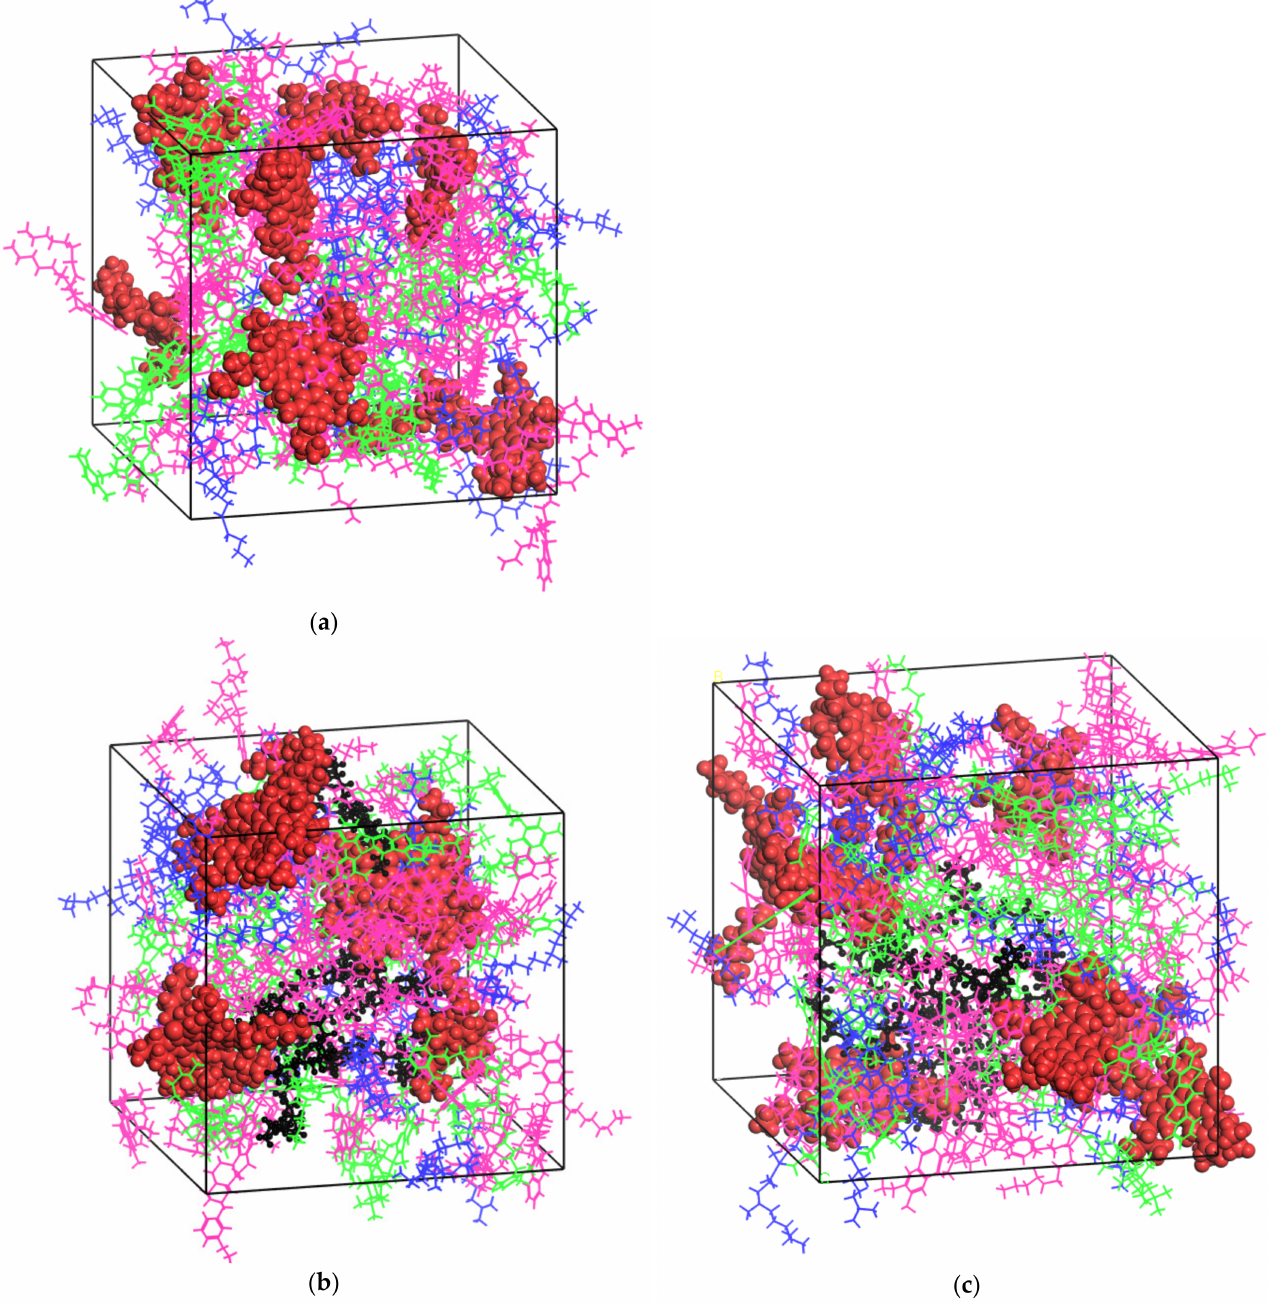
Figure 10. Interaction morphology of virgin asphalt ( a ), RPE-modified asphalt ( b ) and CNT/RPE-modified asphalt ( c ) (red for asphaltenes, green for resins, pink for aromatics, blue for saturates and black for